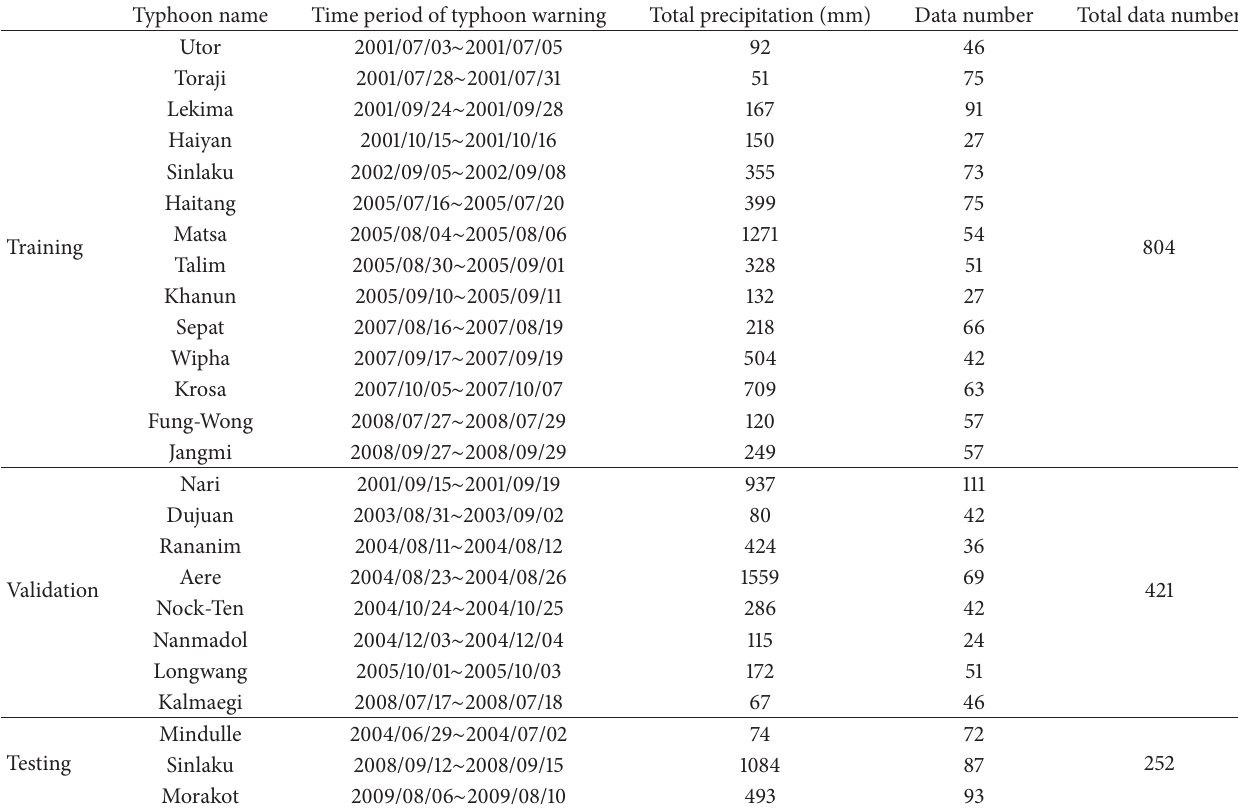
Table 1: The adopted typhoon events among training, validation, and testing